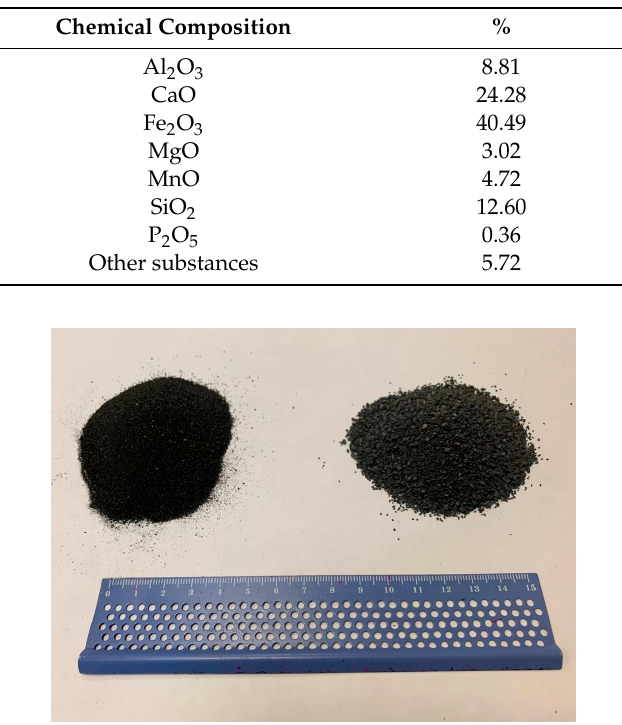
Table 2. Chemical composition of EAF slag.